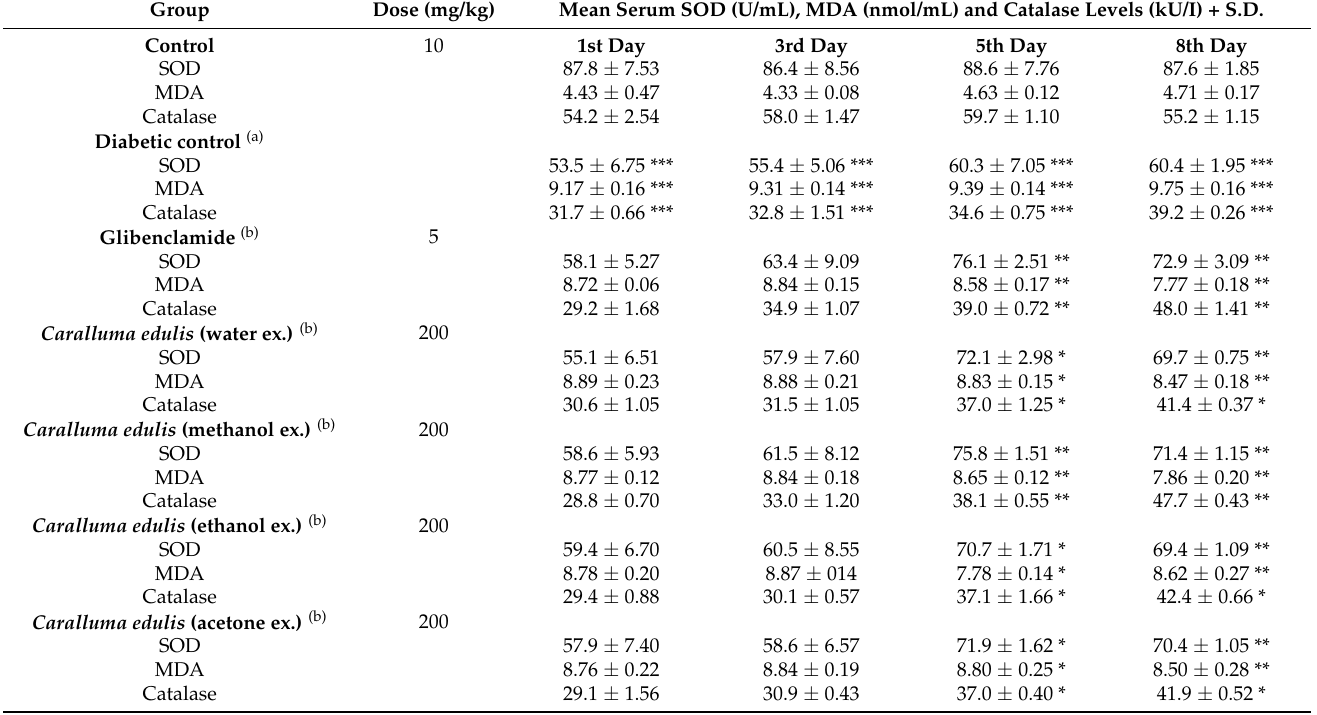
Table 10. Malondialdehyde (MDA), superoxide dismutase (SOD) and catalase levels in serum of alloxan-induced diabetic rabbits after treated with Caralluma edulis extracts.